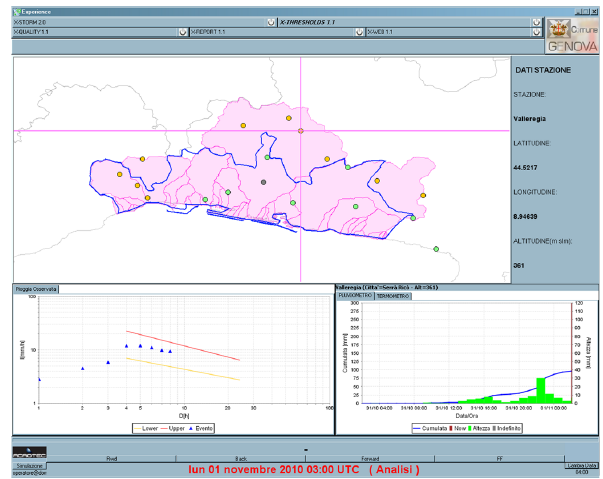
Fig. 12. Genoa Municipality web page (under construction) show- ing the pluviometric thresholds model utilized by the Civil Pro- tection Office (Acrotech, 2008). Top: Genoa Municipality bound- aries (blue line); catchments (pink line); rain gauges (colored dots). Bottom left: intensity/duration diagram (logarithmic scale on both axes), referred to the selected rain gauge (dot marked by crossed lines), showing rainfall thresholds (yellow and red lines) for trigger- ing shallow landslides (from Cevasco et al., 2010). Bottom, right: rainfall amount (blue line) and hourly rainfall amount (green his- togram). As different threshold values are exceeded, the weather station on synoptic (at the top) takes on a different color (dark green).